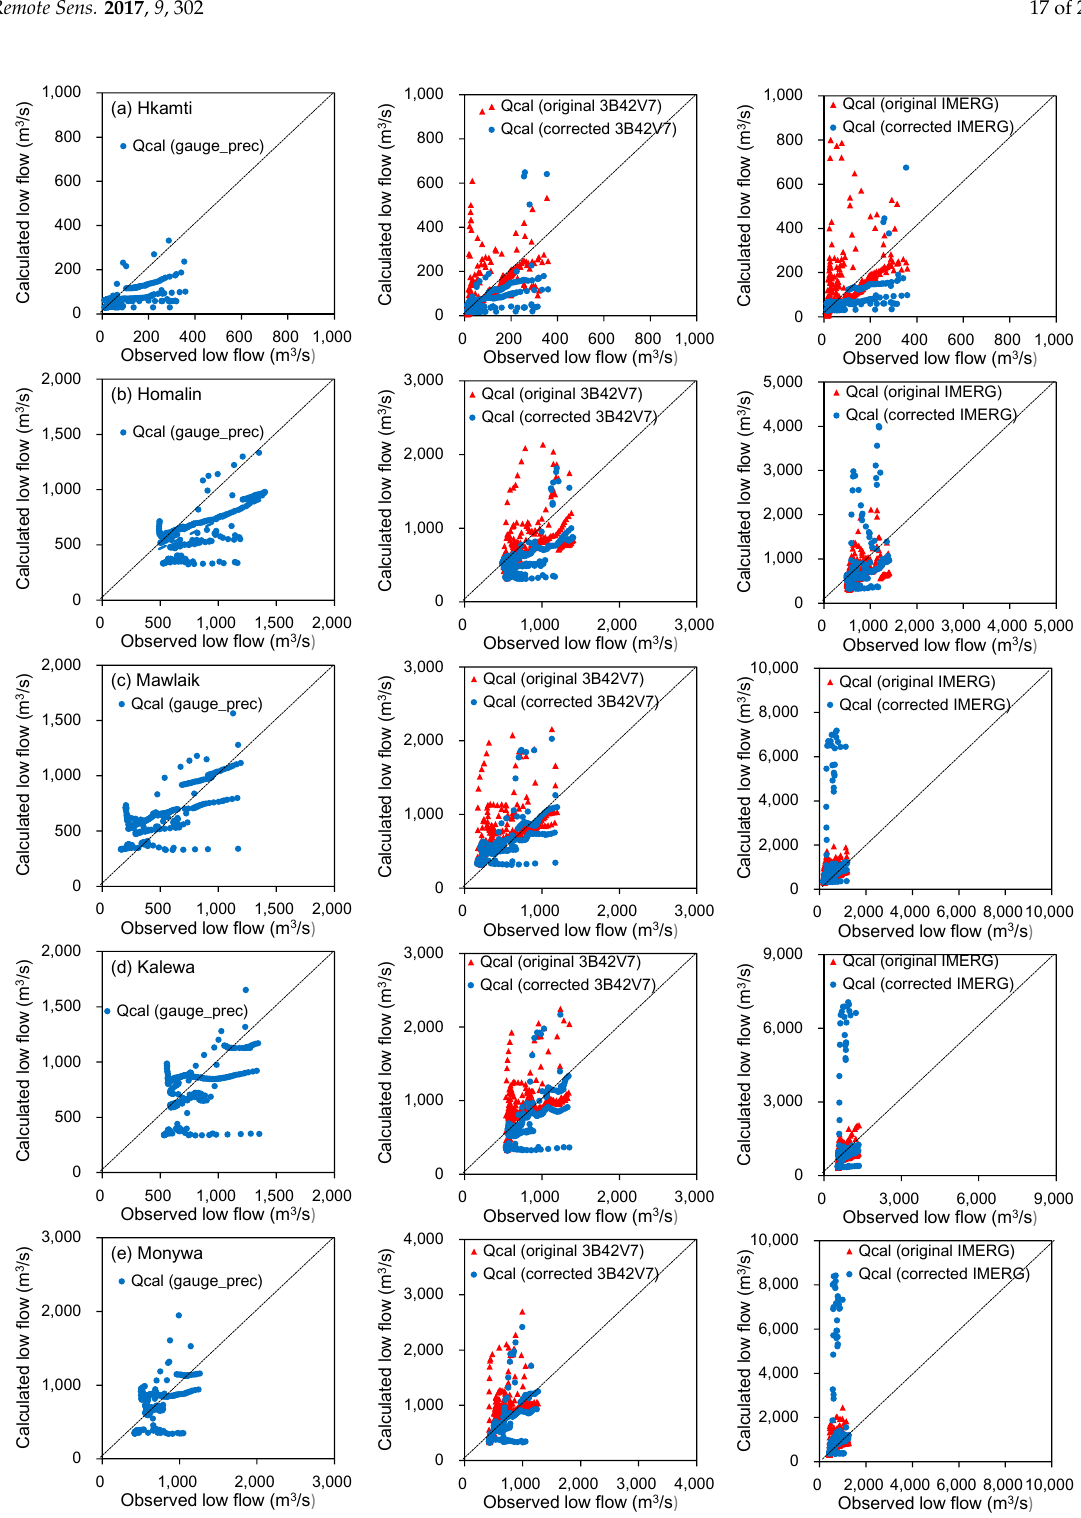
Figure 10. Scatter plots of the simulated low-flow events using the gauge-based precipitation data, the original 3B42V7 and IMERG precipitation estimates, and their corrected data sets at the five streamflow stations in the Chindwin River basin (1 April 2014–31 December 2015). The terms in the figure are the same as in Figure 8.